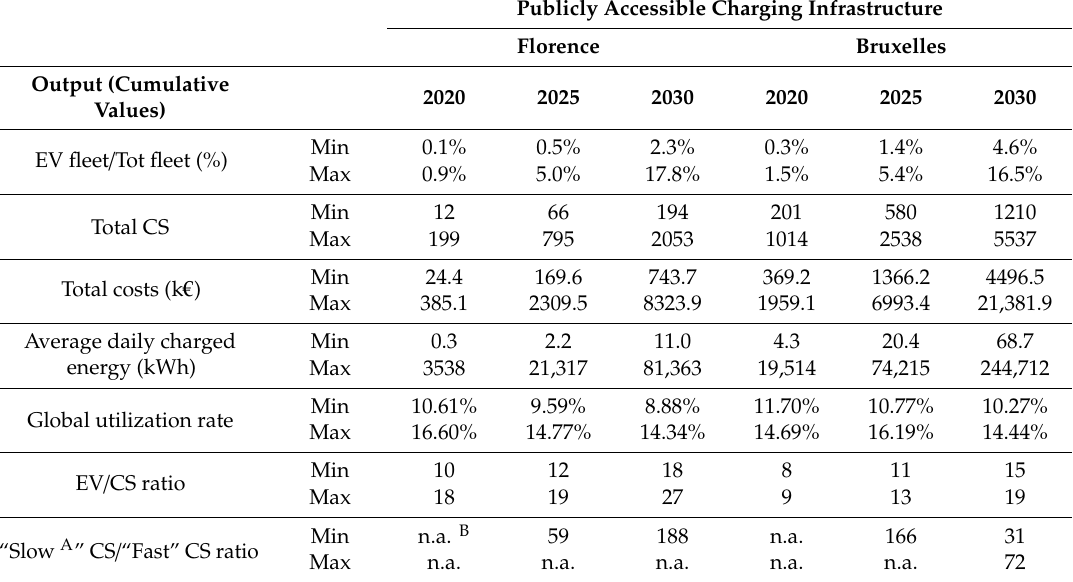
Table 13. Model results for xEV fleet forecast and publicly accessible charging infrastructure for Florence and Bruxelles